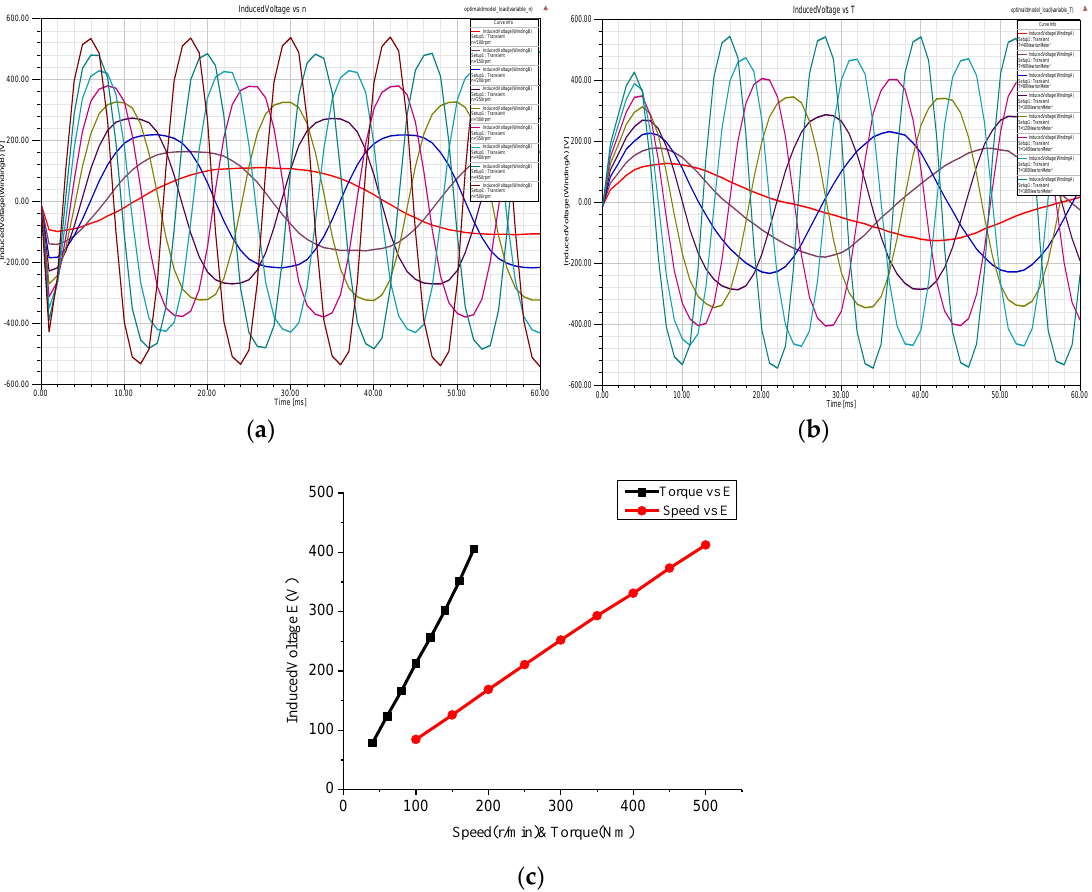
Figure 18. Induced Voltage curves with varied speed & torque. ( a ) simulation curves of induced voltage with varied speed input; ( b ) simulation curves of induced voltage with varied torque input; ( c ) comparison on the induced voltage between varied speed and torque input.